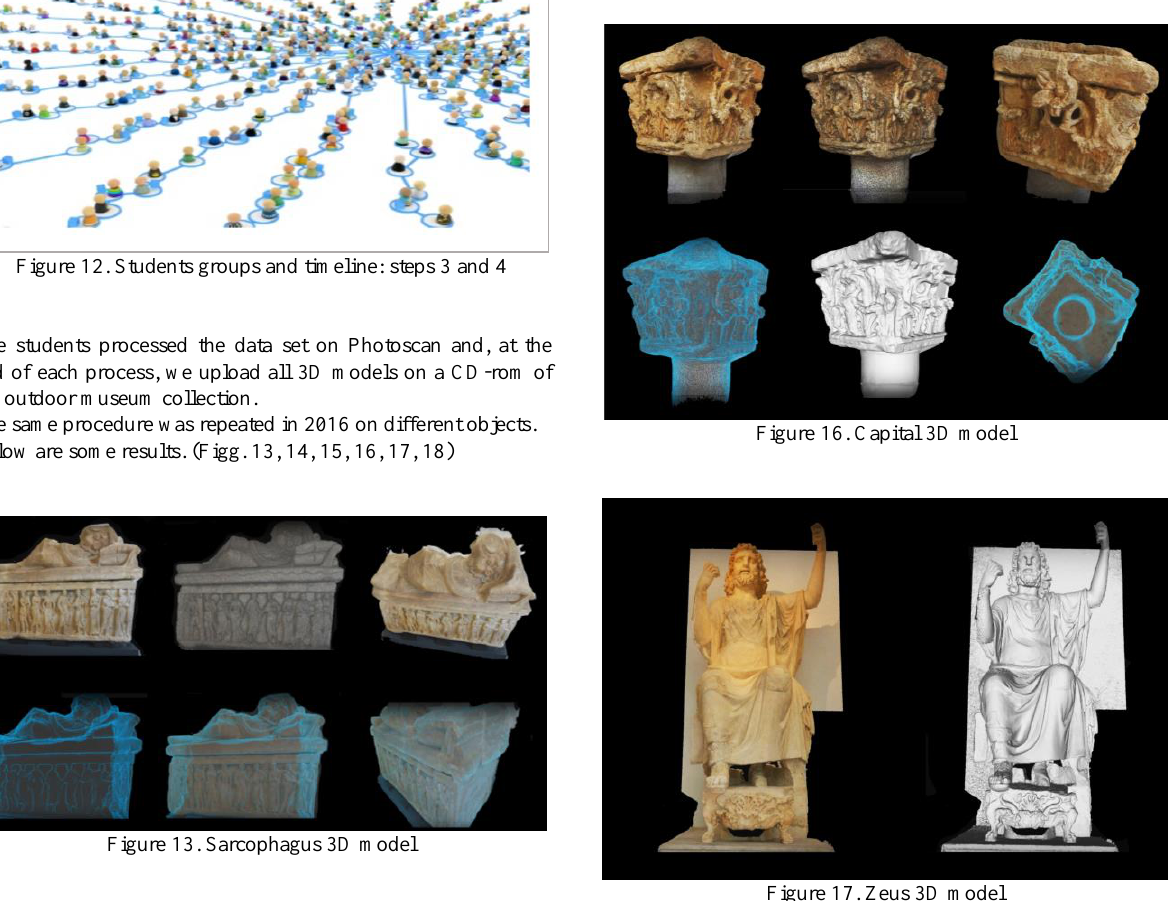
Figure 17. Zeus 3D